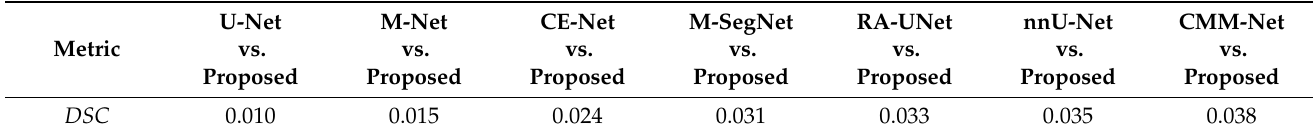
Table 3. p -values from Wilcoxon rank-sum tests for the DSC metric using the PH2 dataset.